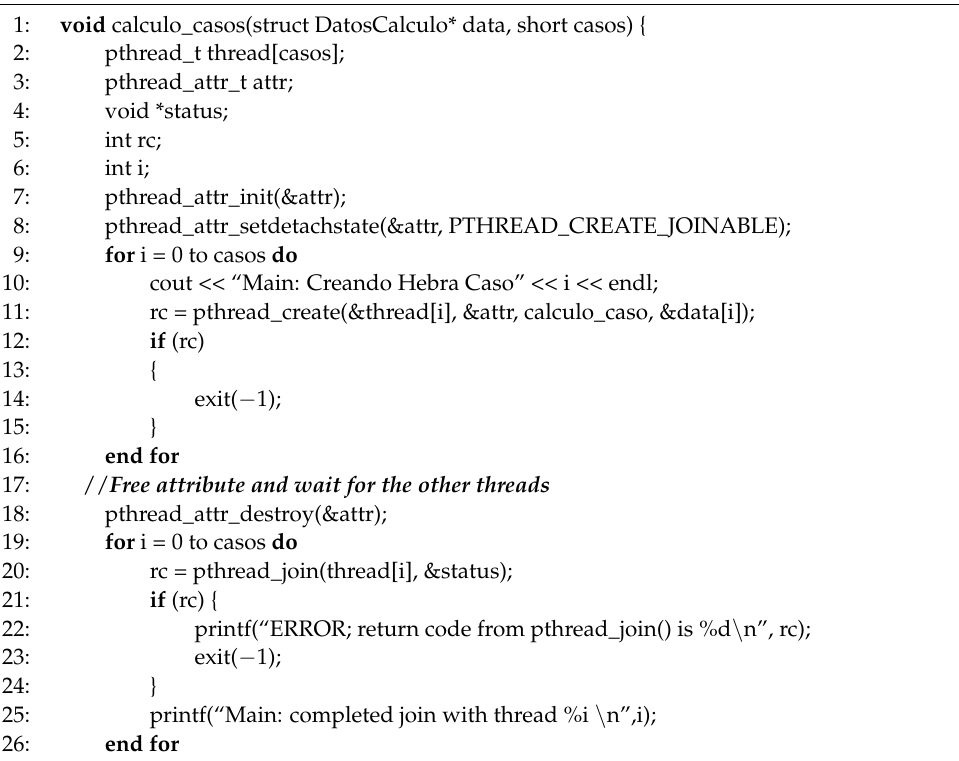
Algorithm 13. Thread Processing